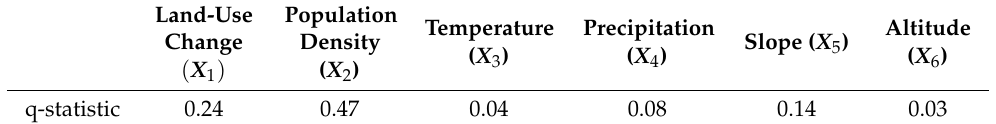
Table 6. Factor detection results.